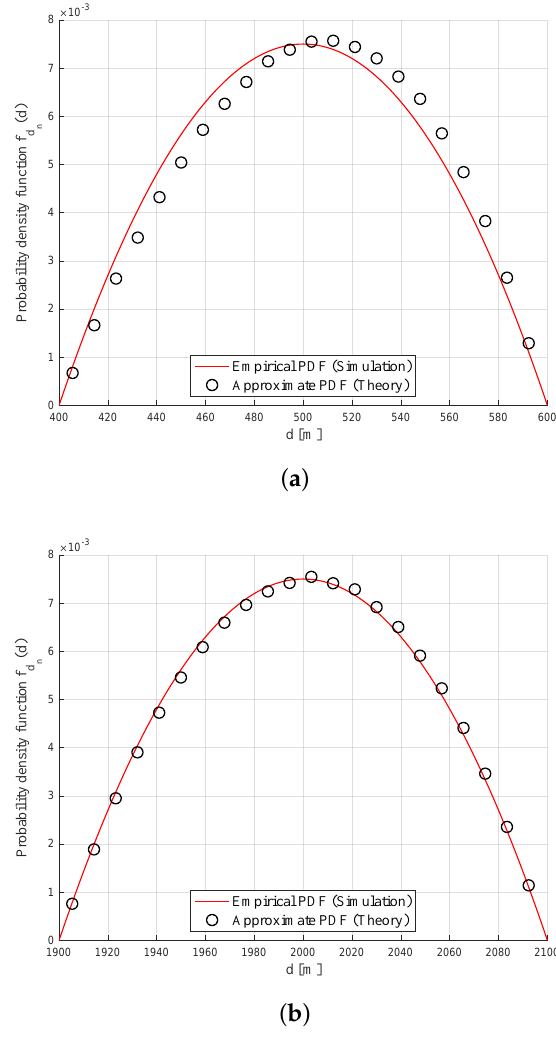
Figure 4. Comparison of the approximate probability density function (PDF) of d n and its empirical PDF based on simulation for R = 100m. ( a ) L = 300 m ( ρ = 3 ) ; ( b ) L = 2 km ( ρ = 20 )